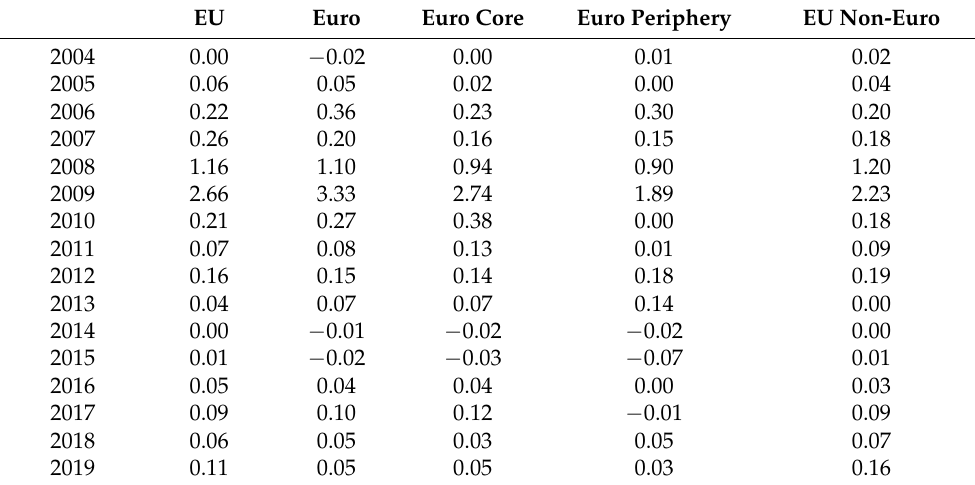
Table 10. Instantaneous quasi-correlations for real GDP growth rates—average of country-level correlation coefficients for different country groups.